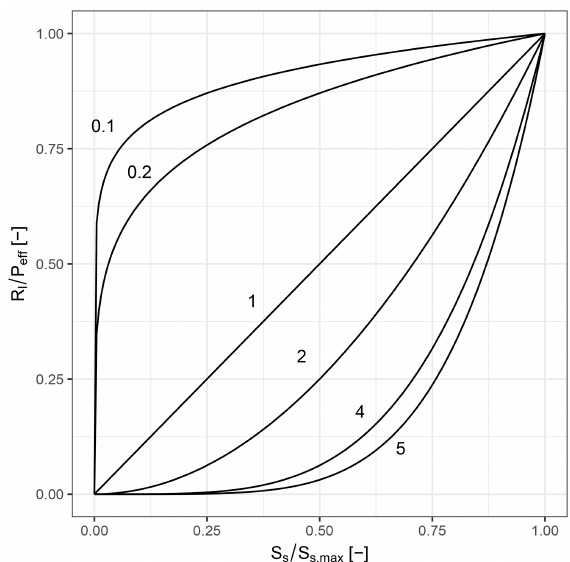
Figure 3. Relation between runoff from land R l as a fraction of ef- fective precipitation P eff and soil saturation S s /S s , max for different values of the runoff coefficient γ in